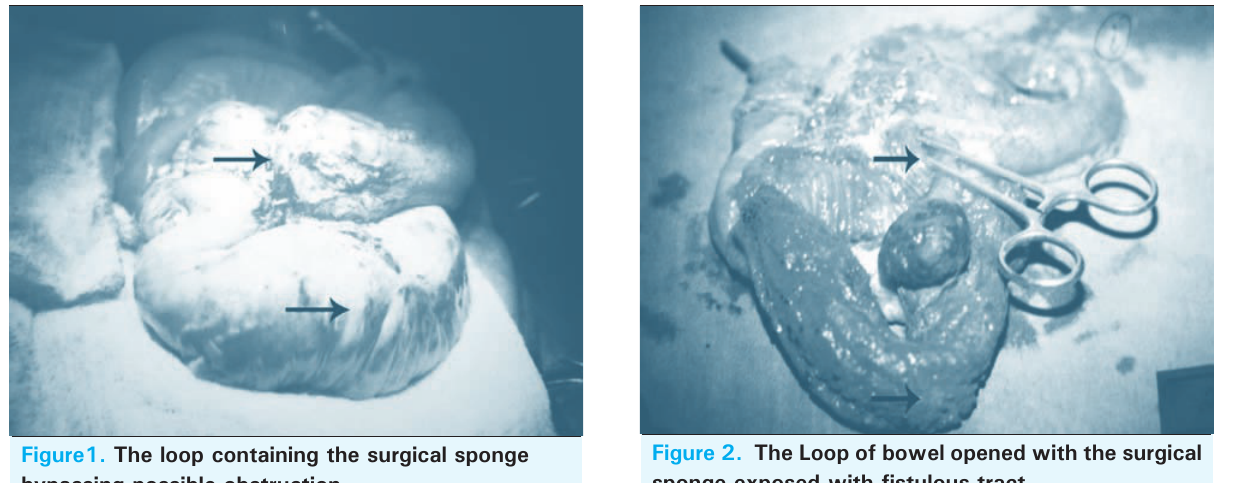
Figure1. The loop containing the surgical sponge bypassing possible obstruction